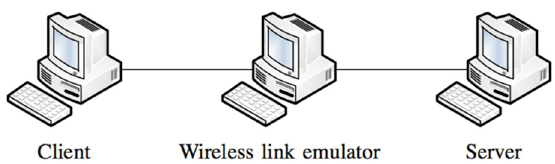
Figure 4. Emulation test topology.